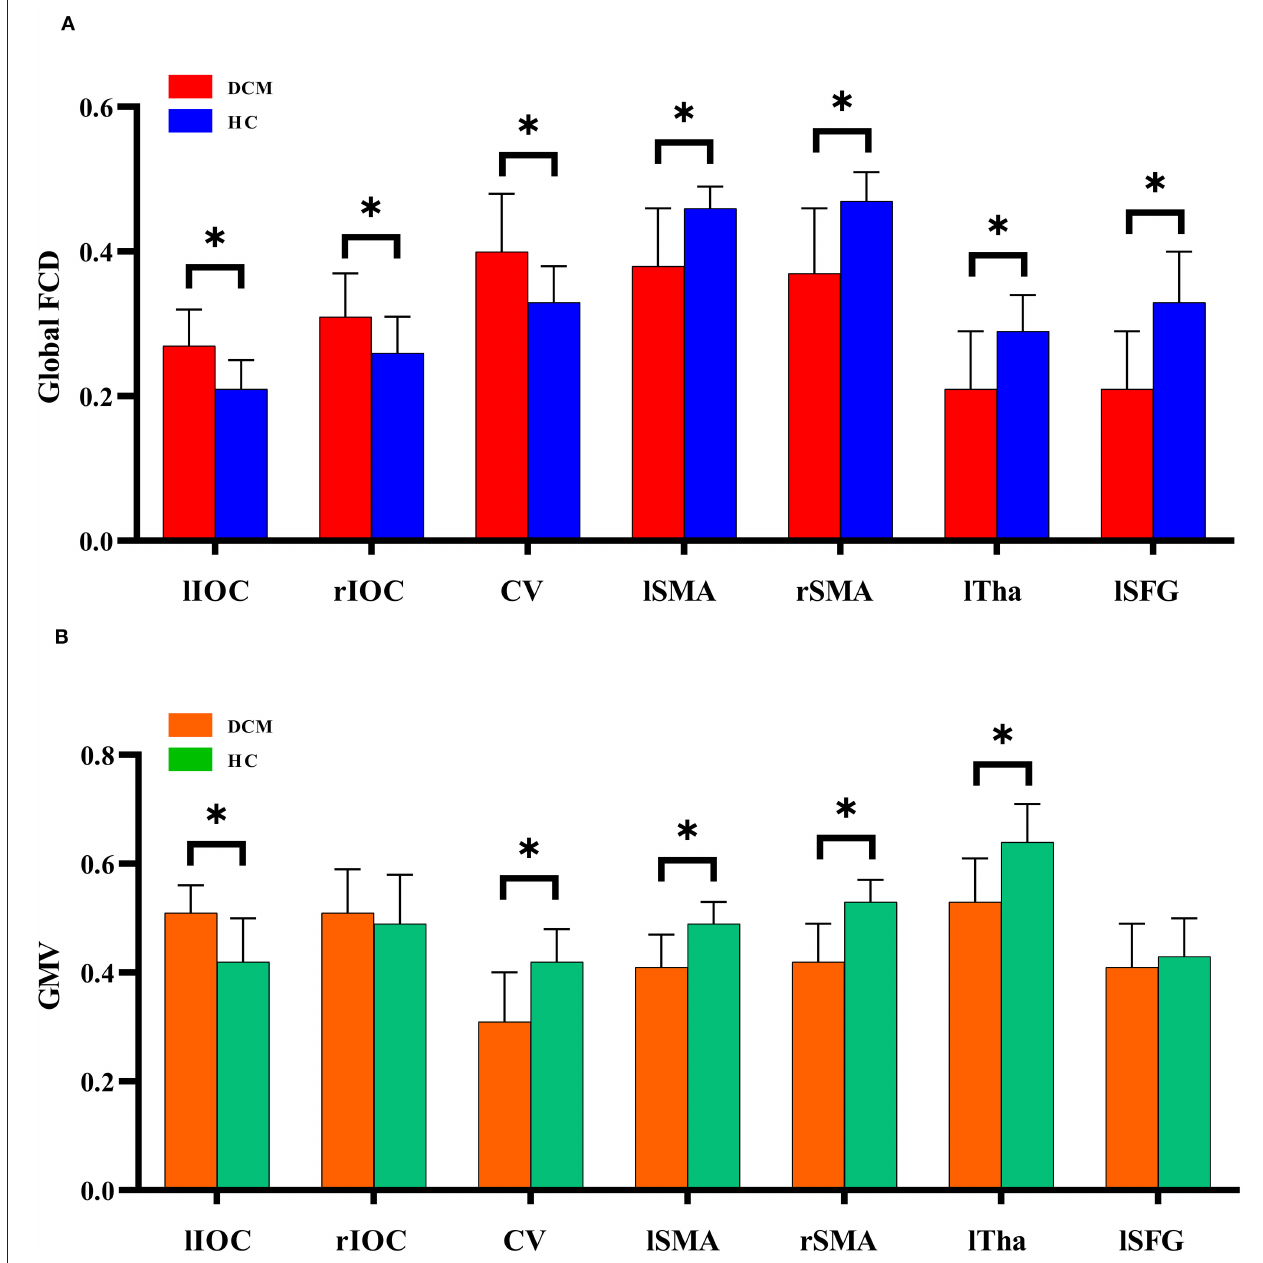
most of these regions, but the spatial distribution pattern of gFCD and GMV differed between regions. gFCD and GMV consistently decreased in regions other than the bilateral SMA and left thalamus and consistently increased in regions other than the left inferior occipital cortices. In the sensorimotor cortex, gFCD and GMV alterations were increased in DCM patients, with increased gFCD and increased GMV simultaneously observed in these